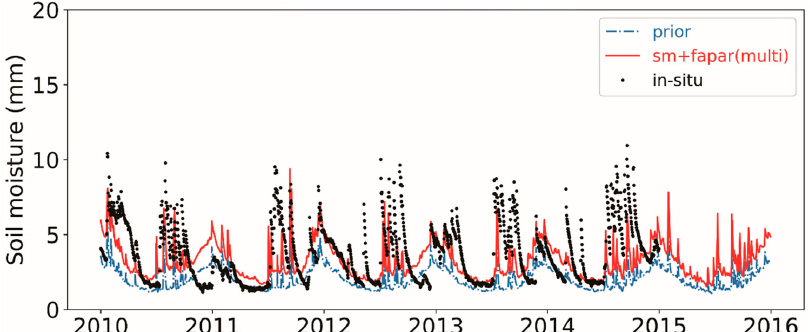
Figure 2. Comparison of simulated surface soil moisture (0–4 cm) at site US ‐ Wkg against in ‐ situ soil moisture observations. The blue dot ‐ dash line denotes the simulation with the prior parameters, the red line denotes multi ‐ site assimilation results with both soil moisture and FAPAR used for the assimilation (‘sm+fapar (multi)’), and the black dot denotes in ‐ situ observations from the FLUXNET sites at the top layer.